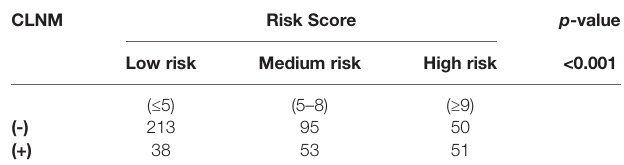
TABLE 4 | Model group